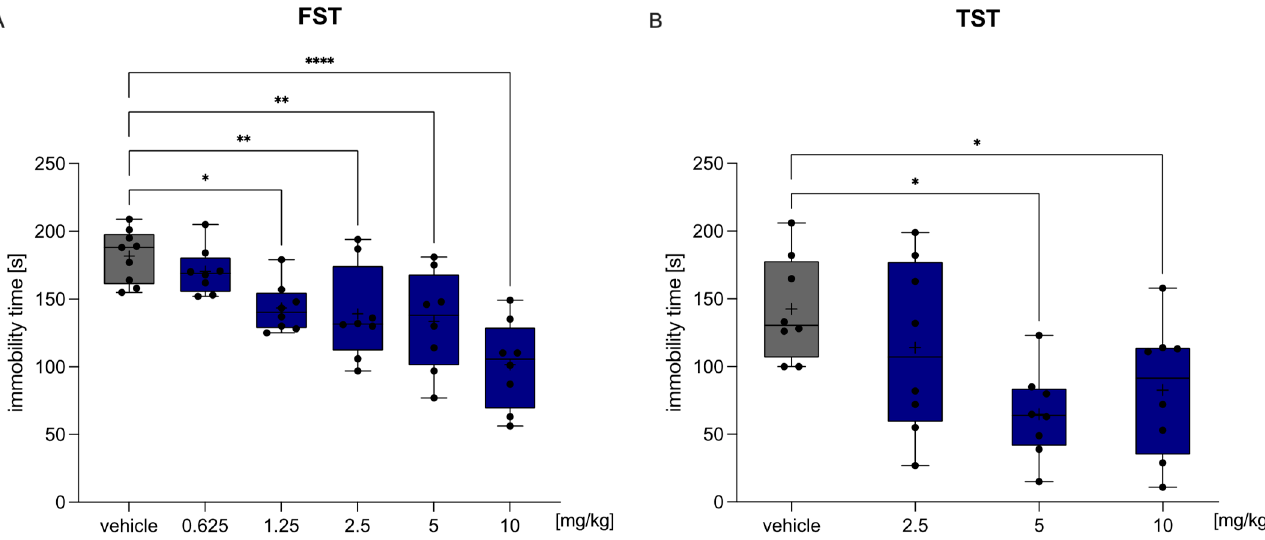
Figure 4. The effect of HBK-10 on the immobility of mice in the forced swim test (Panel ( A )) and on the behavior of mice in the tail suspension test (Panel ( B )). The tested compound or vehicle (1% Tween) were administered 30 min intraperitoneally ( ip ) before the test. The results are presented as box plots showing the following data: mean (‘+’), median (horizontal line), upper and lower quartile (the width of the box shows interquartile range), upper and lower extreme (whiskers). Statistical analysis: Shapiro–Wilk test for normality, Brown–Forsythe test for homogeneity of variance, and one-way ANOVA (Newman–Keuls post hoc); * p < 0.05, ** p < 0.01, **** p < 0.0001; n = 8–9 mice per group.